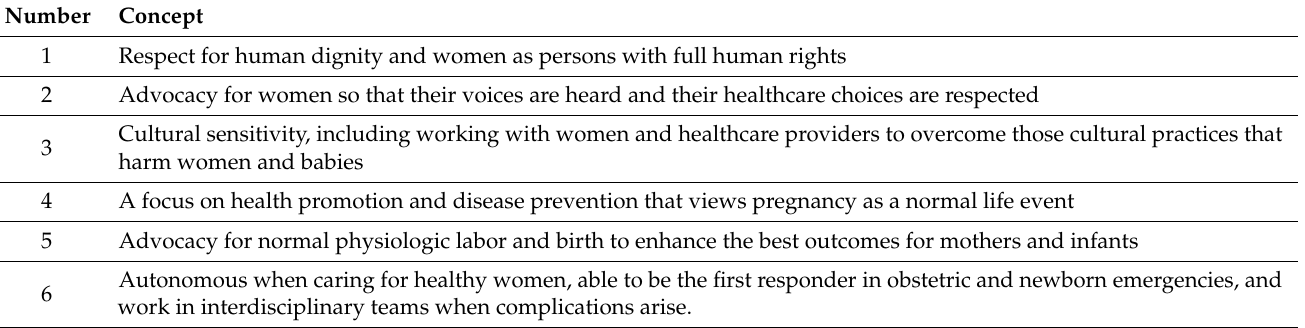
Table 3. Key concepts of the profession of midwifery by the International Confederation of Midwives